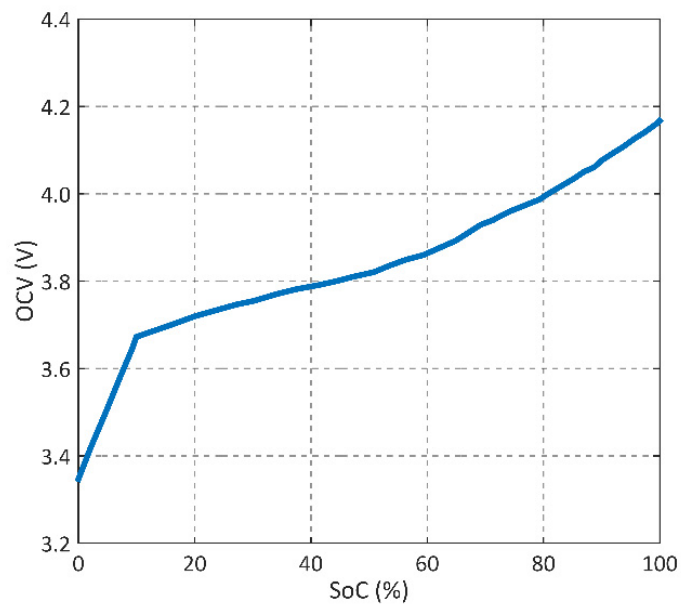
Figure 5. OCV vs. SoC profile.